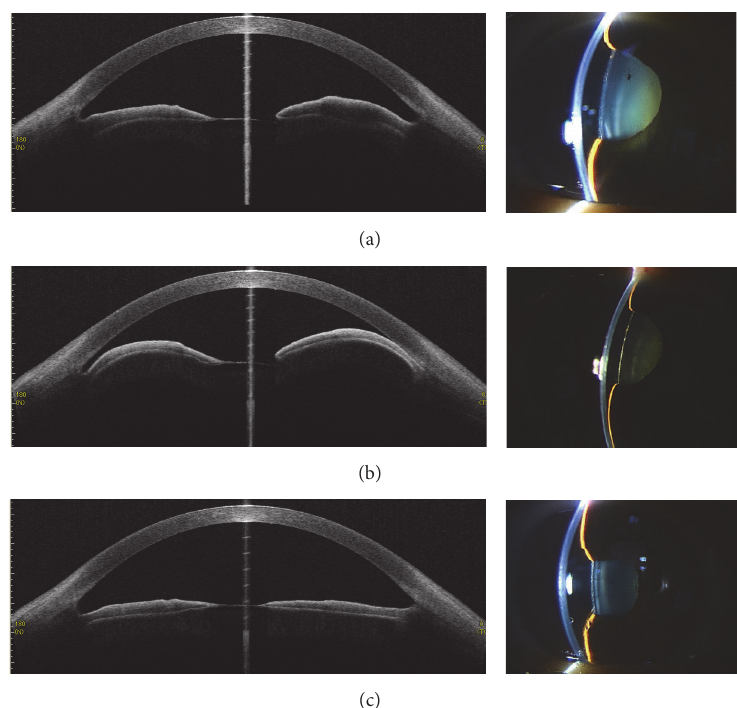
Figure 2: Representative anterior segment optical coherence tomography (AS-OCT) images (left) and slit-lamp images (right) showing (a) preattack, (b) attack, and (c) post-LPI.